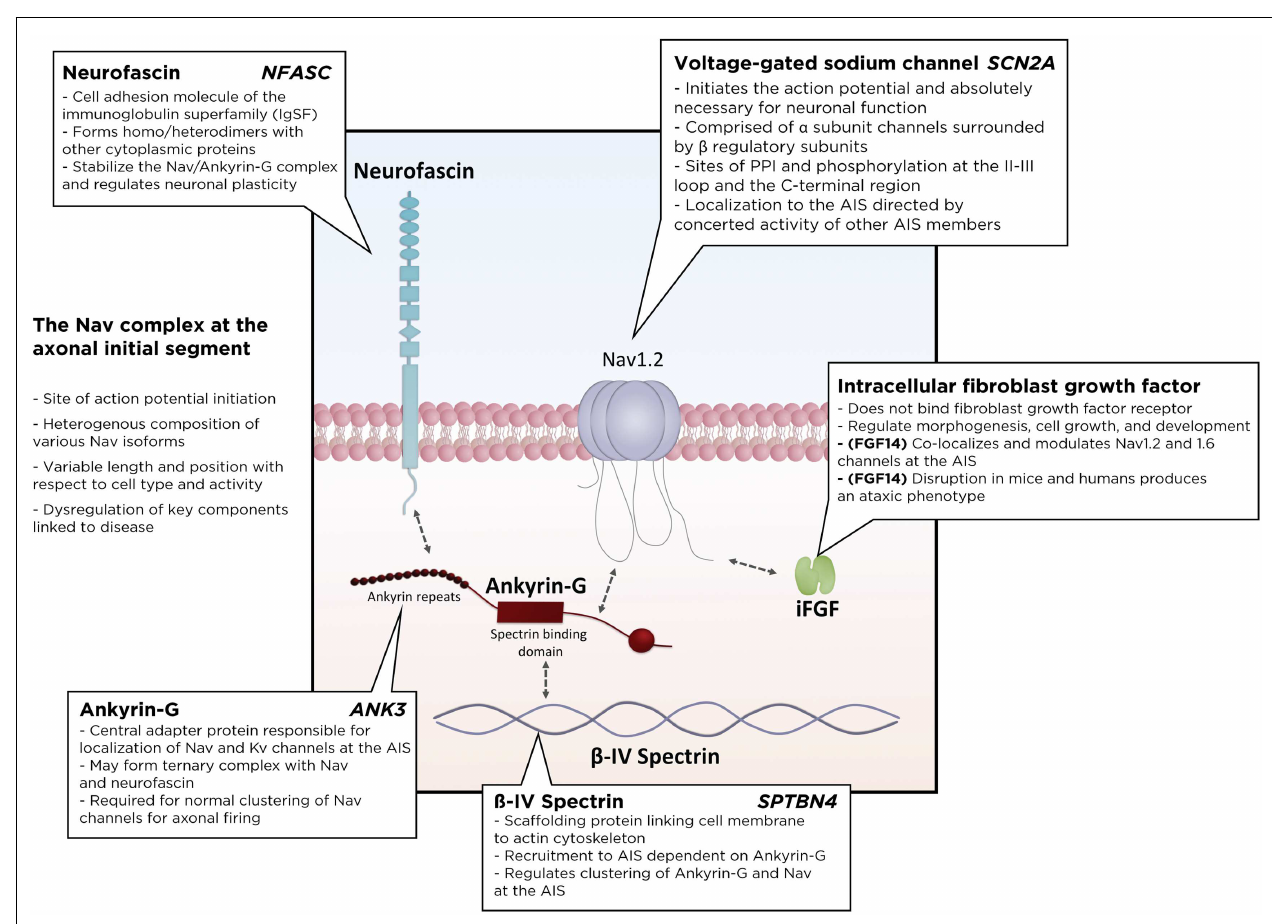
FIGURE 2 | Schematic of the Nav macromolecular complex at the axonal initial segment (AIS) .Voltage-gated sodium channels form a tightly regulated complex with several critical regulatory and scaffolding proteins, including ankyrin-G, β 4-spectrin, neurofascin, and intracellular fibroblast growth factors. PPI, protein–protein